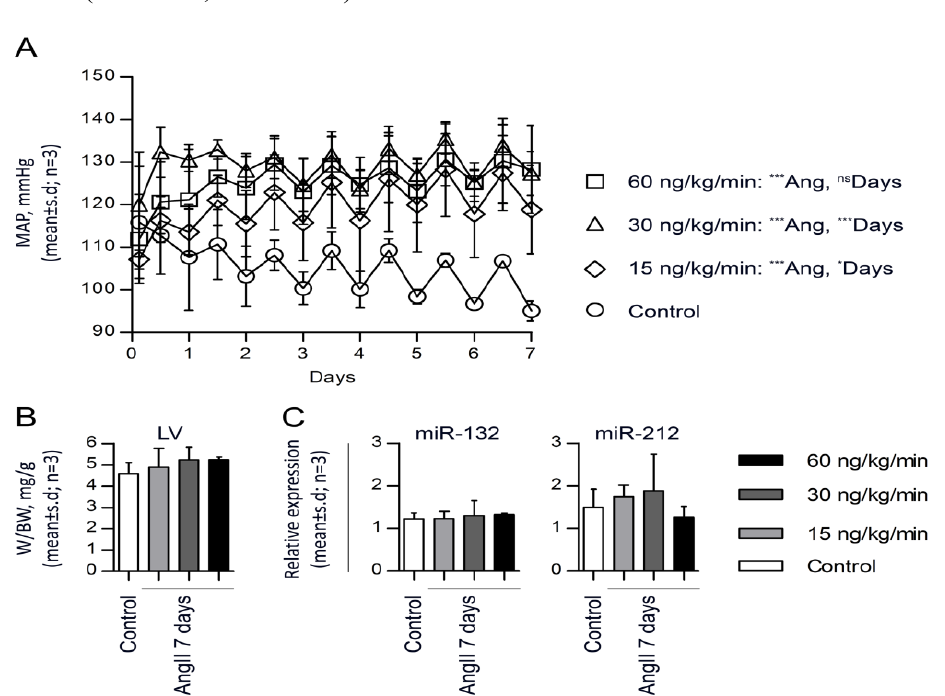
Figure 3. Validation of miRNA regulation in AngII-induced hypertensive mice hearts. ( A ) Mean daily averages of mean arterial blood pressure from three mice treated